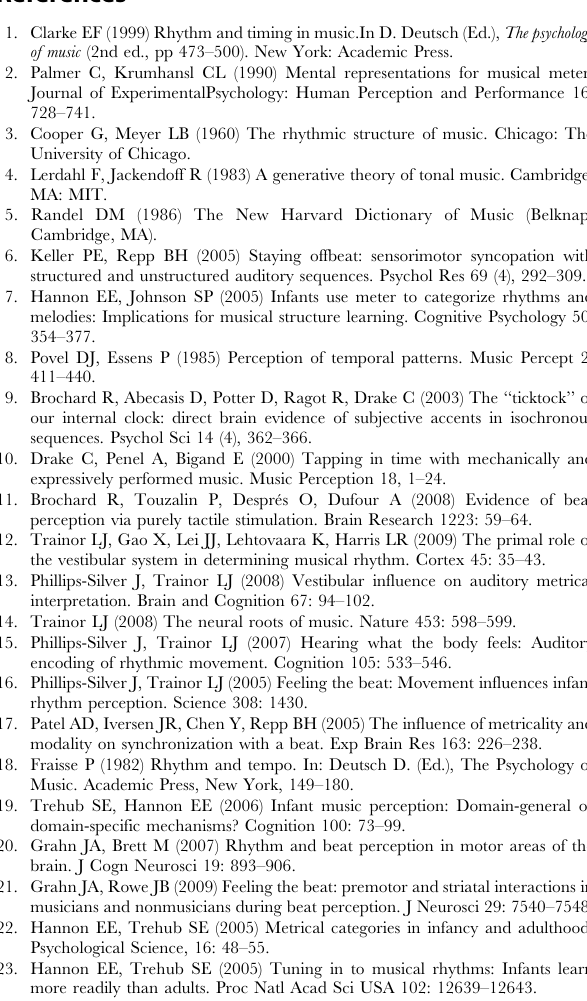
Figure S1 Results of Experiment 2, meter recognition in duple sequences for bimodal M/N split and M/N half split tasks. (A) duple sequences tested in the M/N split task, (B) duple sequences tested in the M/N half-split task. Open bars are results tested under unimodal condition. Hashed bars are results tested under bimodal condition. Error bars are standard